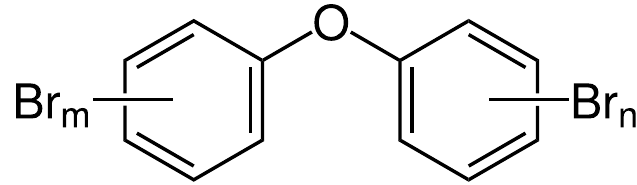
Figure 1. Structure of polybrominated diphenyl